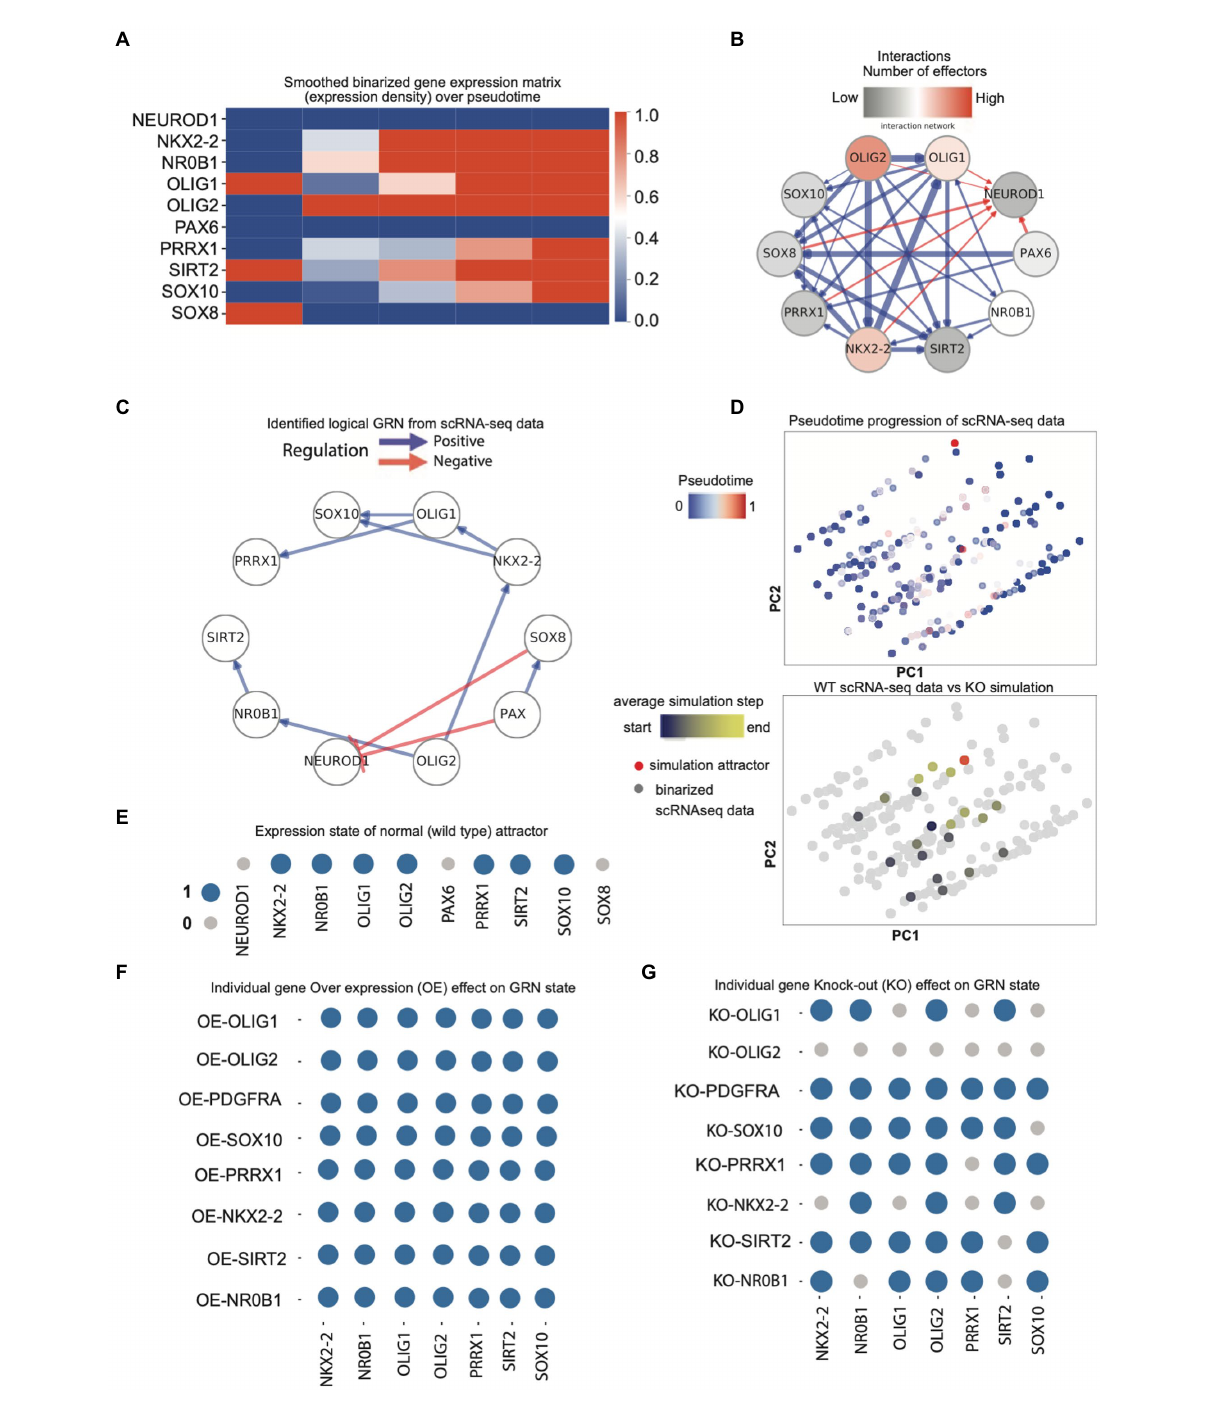
FIGURE 3 (A) Initial smoothed binarized gene expression states for neuronal and OPC genes (expression density). Gene expression values are binarized by clustering, then averaged over a pseudo-time window, and thereafter sorted based on transition points from early to late. Red means high expression and blue means low expression; (B) the set of all possible gene–gene interactions, filtered by interaction hierarchy and mutual information. Positive and negative interactions are represented by blue and red edges, respectively. Edge width represents the relative amount of mutual information of the interaction. (C) The provisional GRN for OPC lineage genes shows the direction of gene regulation for selected candidates. The GRN is obtained by constraining the possible interactions both to follow the in vivo data progression when executed as a logical network and maximize the mutual information between gene pairs. Positive and negative interactions are represented by blue and red edges, respectively. (D) Upper panel: The PCA plot of the binarized scRNA-seq data color-coded with the pseudo-time values attributed to each cell. The binarization is performed by clustering the scRNA-seq expressions into expressed or not expressed levels; lower panel: The PCA plot of the simulated developmental trajectories is overlaid on the binarized scRNA-seq. The detected attractor is colored red. The simulated data are color coded by the value of the average simulation step (average distance to the attractor of simulation); (E) Expression states of the GRN model steady-state attractor. Genes that are expressed (1) and not expressed (0) are represented with blue and gray circles, respectively; (F) Expression states of the model attractors under sequential overexpression (OE) perturbations; (G) Expression states of the model attractors under knock-out (KO)